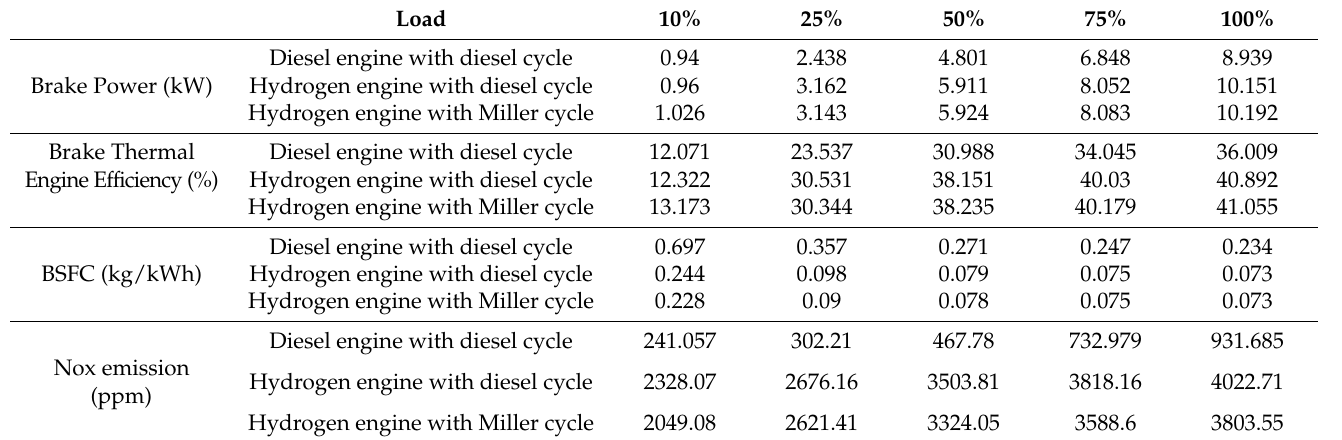
Table 7. Comparison of BP (kW), BTEE (%), BSFC (kg/kWh) and NOx emissions (ppm) for diesel cycle diesel engines, diesel cycle hydrogen engines and miller cycle hydrogen